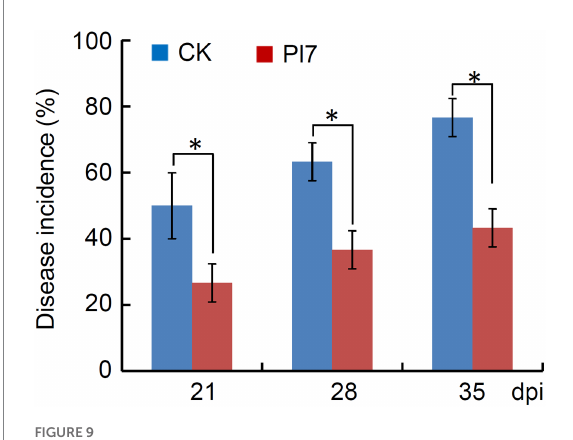
FIGURE 9 Statistical analysis of disease incidence of B. halotolerans strain Pl7-treated apple fruits. After treatment with strain Pl7, the number of rotted fruits was recorded at different storage time points (21, 28, 35 days). Each treatment contained of three replicates and each replicate consisted of 10 fruits. Disease incidence (%) represents the percentage of the number of rotted apple fruits out of total treated apple fruits. Data are presented as the mean of disease incidence ± SD of three biological replicates. Asterisks above the bars represent significantly different ( p < 0.05; Student’s t -test) between CK and treatment. This experiment was performed independently two times with similar results.